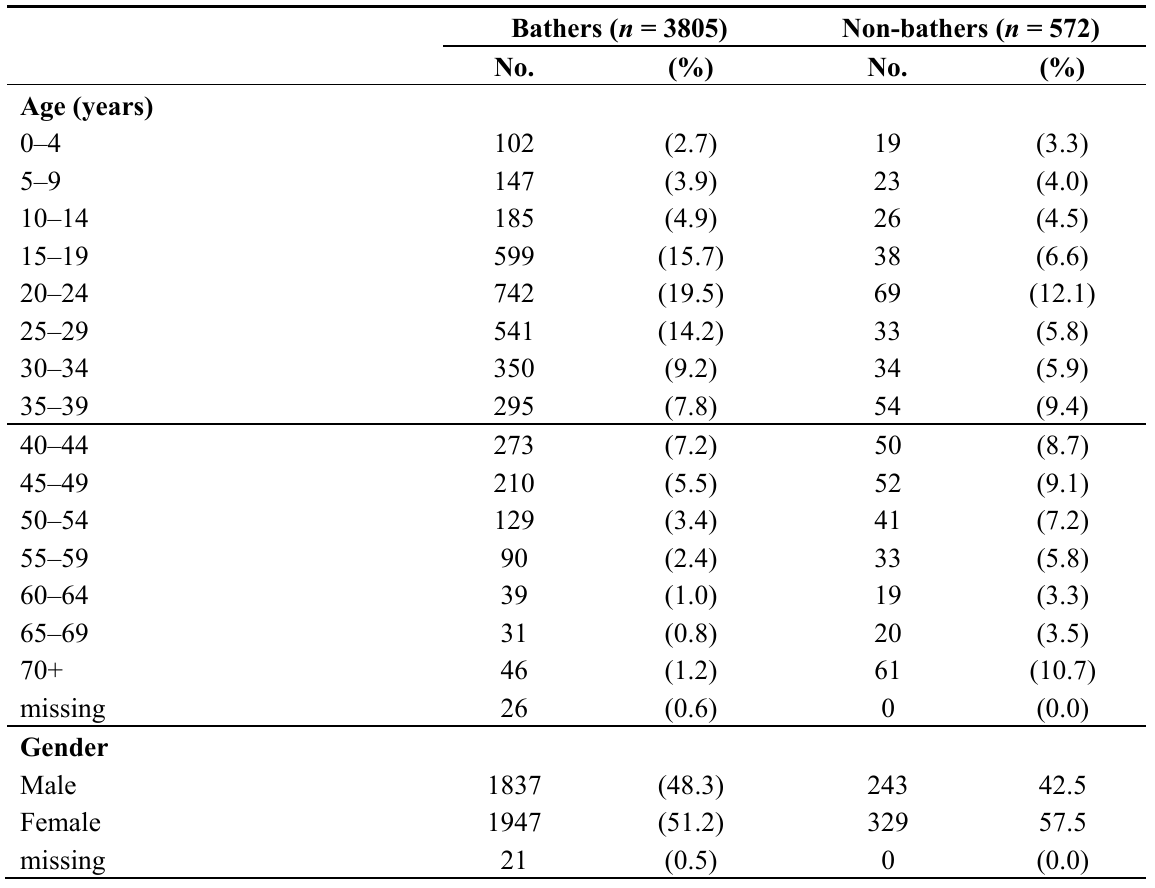
Table 1. Characteristics of bathers and